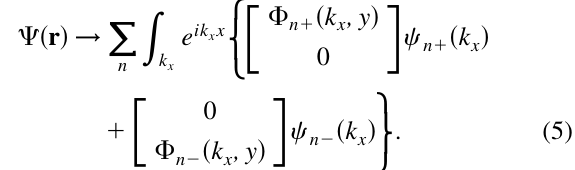
FIG. 2. (a) Schematic illustration of the gate-defined quantum wire. (b) Main plot: Band structure for a W ¼ 800 - (cid:5)A gate- defined quantum wire residing in a d ¼ 70 - (cid:5)A HgTe quantum well. The material parameters used appear in Table I, while the depth of the confining potential is V ¼ 0 : 025 eV . Note that each band is doubly degenerate. Insets: Illustration of the wave- in the n ¼ 2 function components (cid:2) n;E=H þ separately in the three regions of Fig. 2(a) and then matching boundary conditions (see Appendix A for details). Below, we simply highlight some salient features of the problem.